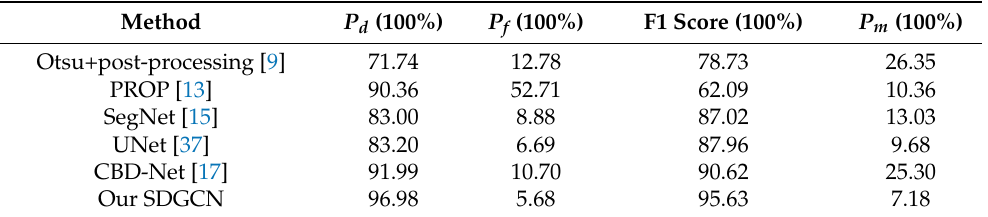
Table 4. Comparison between our proposed SDGCN algorithm and different dark spot segmenta- tion